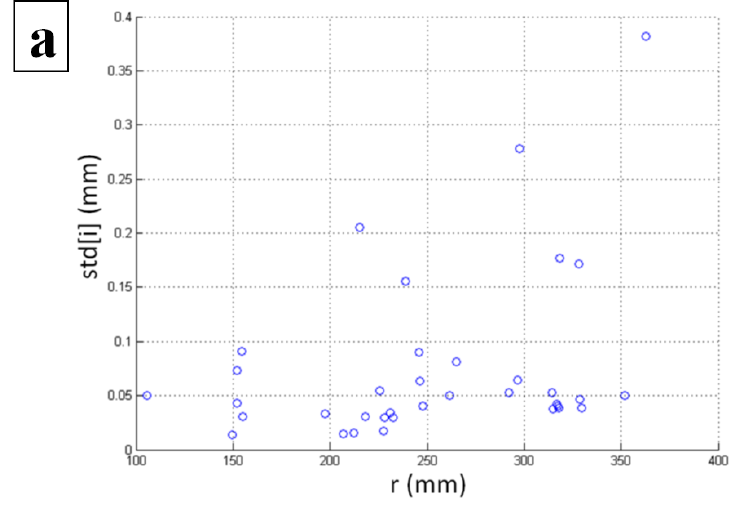
Figure 7. Spatial dependency of ( a ) the radius— r ; ( b ) inclination—θ; and ( c ) azimuth—φ' on the standard